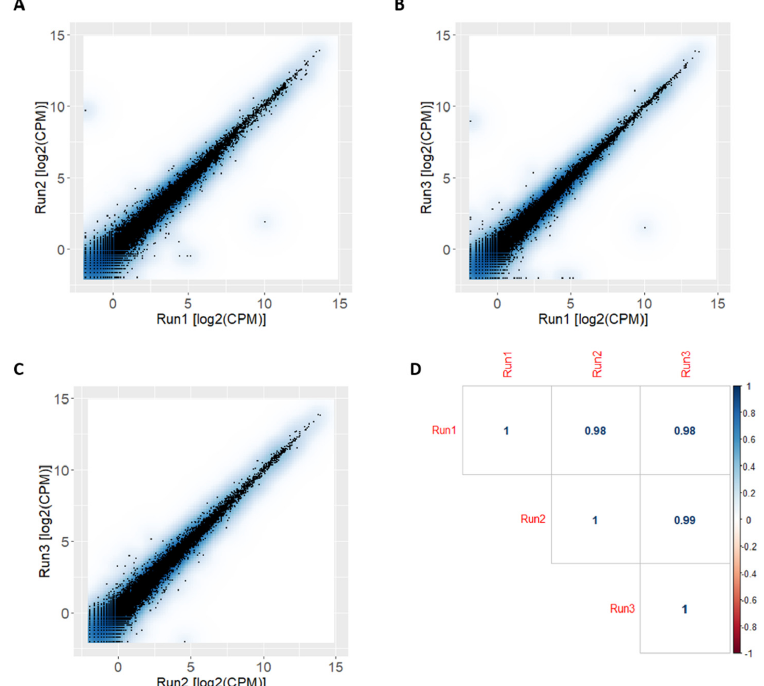
Figure 2. Correlation analysis comparing the three libraries. ( A ) Scatter plot of log 2 (CPM) values from run1 vs. run2. ( B ) Scatter plot of log 2 (CPM) values from run1 vs. run3. ( C ) Scatter plot of log 2 (CPM) values quantified from run2 vs. run3. ( D ) Correlation matrix with Pearson correlation coefficients. Thus, data obtained from these runs were combined to obtain a large dataset (here- inafter DS100) for the evaluation of ONT performance as a function of read number. length of 483.2 base pairs (bp) that passed the quality filter. We used this total dataset to generate progressively fractional synthetic subsets (90% to 5%, i.e., DS90 to DS5). The total and mapped reads are reported in Table 1 for each dataset. Table 1. The numbers of total and mapped reads are reported for each subset (DS90–DS5) and the total dataset (DS100). The numbers of mapped reads for the subsets are the average among 10 ran- domly picked replicated subsets with the same size (CV < 0.8%). Dataset Avg. Total Reads Avg. Mapped Reads DS100 48,495,343